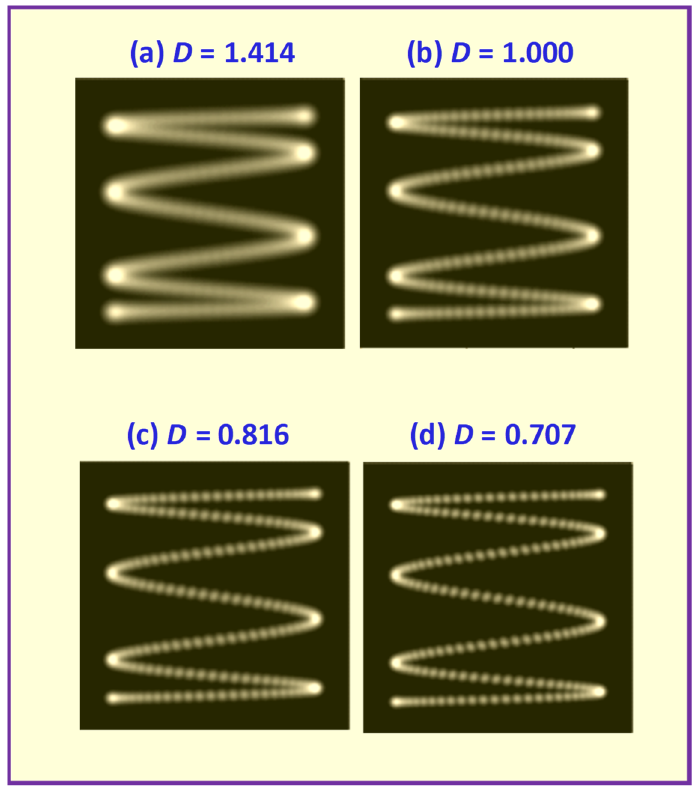
Figure 12. Numerical results for Lissajous transverse patterns varying from the continuous curves to the discrete spots with ( a ) D = 1.414; ( b ) D = 1.000; ( c ) D = 0.816; ( d ) D = 0.707.